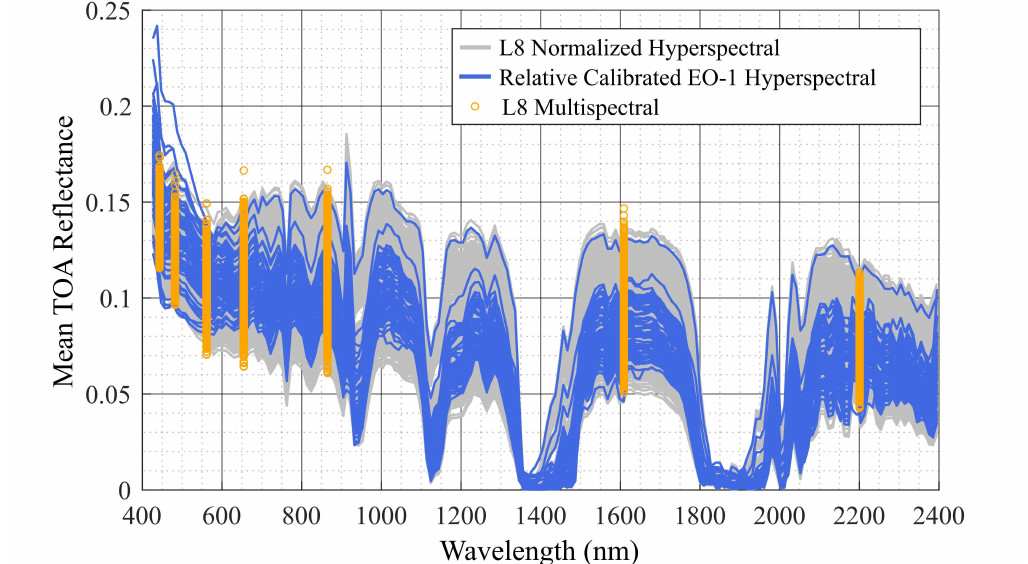
Figure 14. L8-normalized hyperspectral TOA reflectance (grey line), EO-1 hyperspectral TOA re- flectance after relative gain correction (blue line), and L8 multispectral TOA reflectance (orange circle). The DaHD consists of a combination of L8- and S2A-normalized hyperspectral pro- files, a total of 1925 (M = 1150, N = 775) profiles. The DaHD, consisting of reflectance measurements in the range of 0.04–0.2, was then used to develop the DAHAC model.